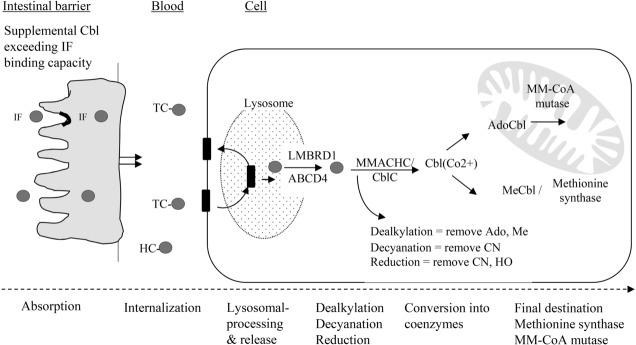
Trafficking and assimilation of all forms of Cbl into mammalian cells is likely to follow the same steps: crossing the intestinal barrier, cellular internalization, lysosomal release, dealkylation, decyanation or reduction, forming the coenzymes and then attachment to the corresponding enzymes. Ado; adenosyl, CN; cyano-, HC; haptocorrin, HO; hydroxyl, IF; intrinsic factor, LMBRD1 and ABCD4; are lysosomal membrane exporters, Me; methyl, MMACHC; methylmalonic aciduria and homocystinuria type C protein, MM-CoA: methylmalonyl-CoA, TC; transcobalamin.